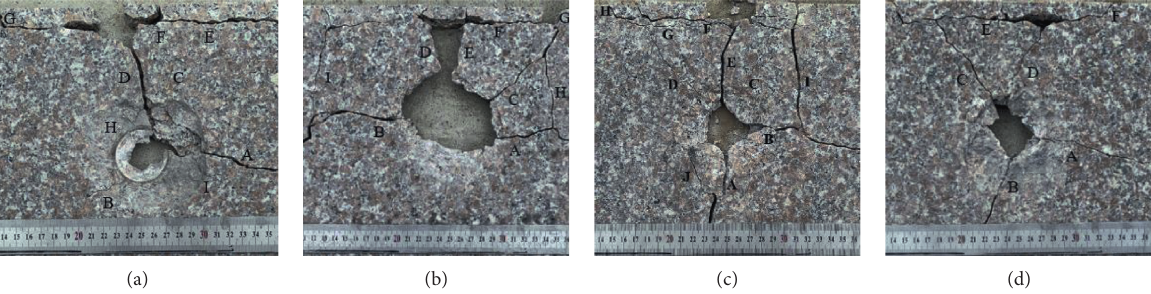
Figure 7: Specimen failure morphology with different borehole diameters. (a) Test 1, (b) test 2, (c) test 3, and (d) test